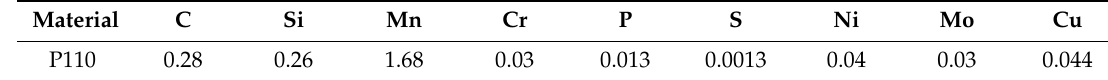
Figure 9. Gas-solid experimental system; ( a ) flow chart; ( b ) erosion test image. Table 4. Chemical composition of P110.